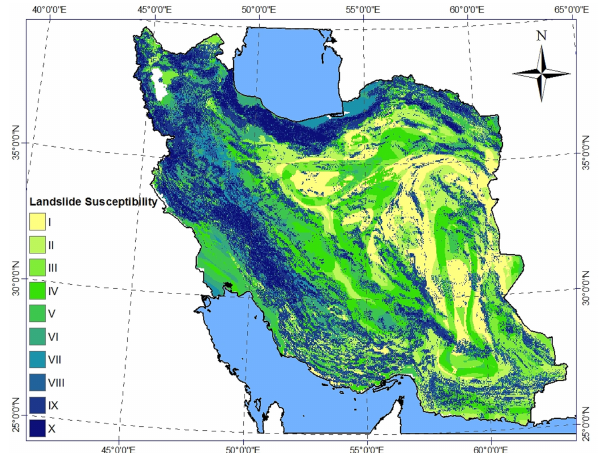
Figure 12. Landslide susceptibility map of Iran (GSI, 2018).